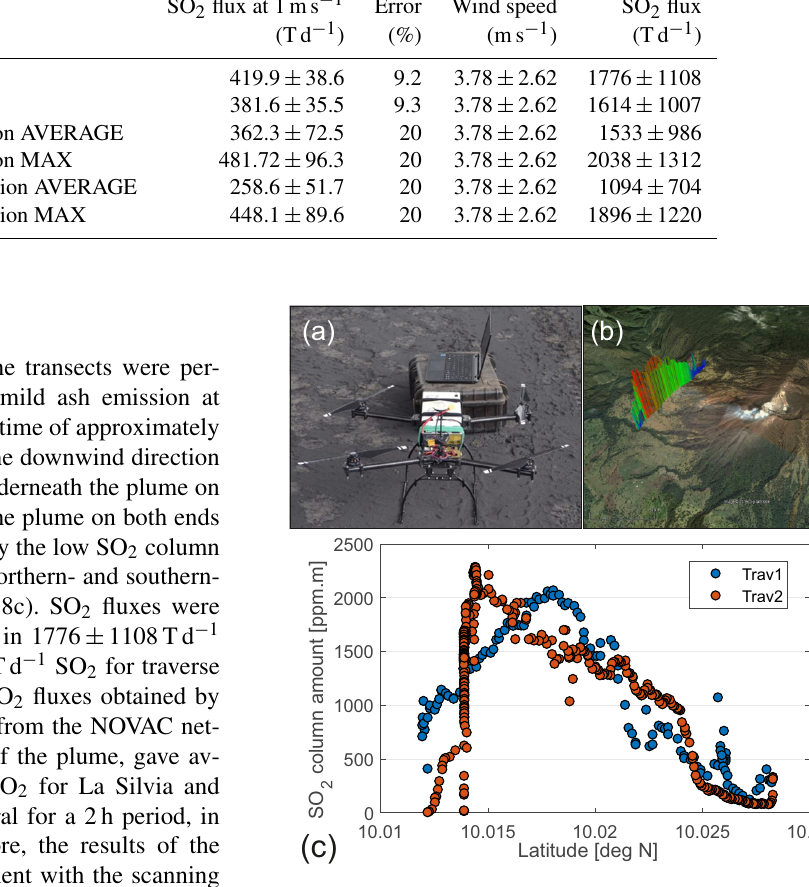
Figure 8. (a) Drone-operated miniature DOAS setup, (b) Illustra- tion of SO 2 column amounts measured by DROAS at Turrialba vol- cano, (c) SO 2 column amounts during the transversal flight under- neath the